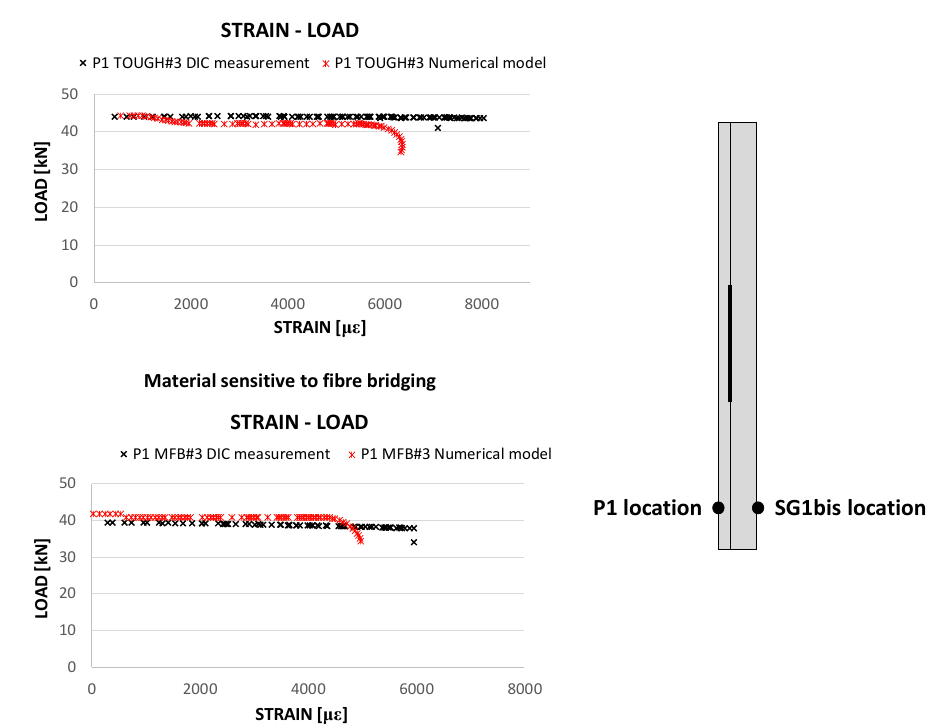
Figure 17. Compressive load as a function of the DIC measured strains: comparison with the numerical results. Polymers 2020 , 12 , x FOR PEER REVIEW